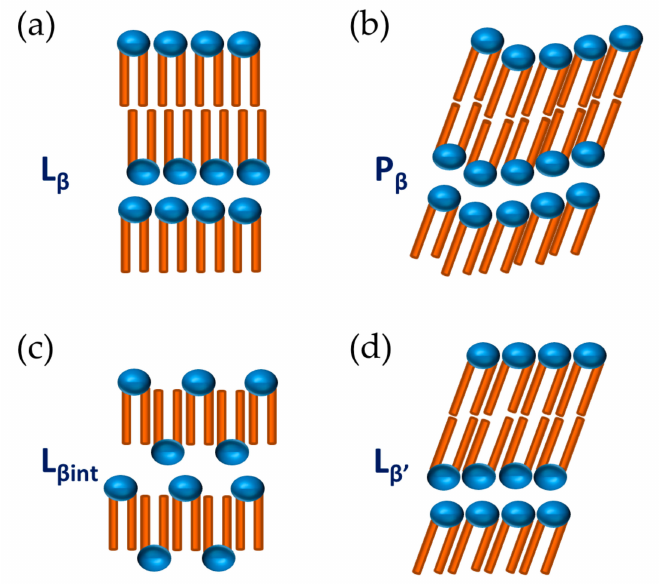
Figure 3. Various structures of bilayers in the gel phase. ( a ) Gel phase, L β ; ( b ) Rippled gel phase, P β ; ( c ) Interdigitated gel phase, L β int ; ( d ) Tilted gel phase, L β ’.